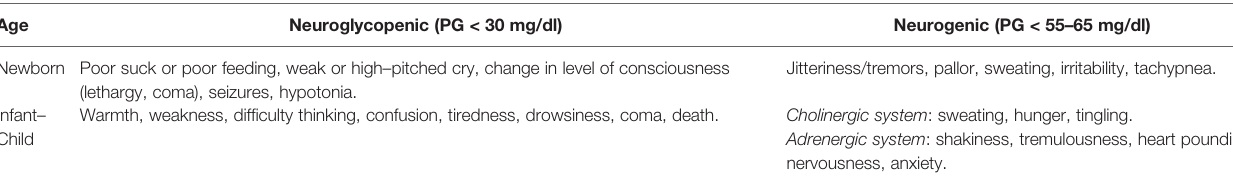
TABLE 1 | Symptoms and signs of HY.